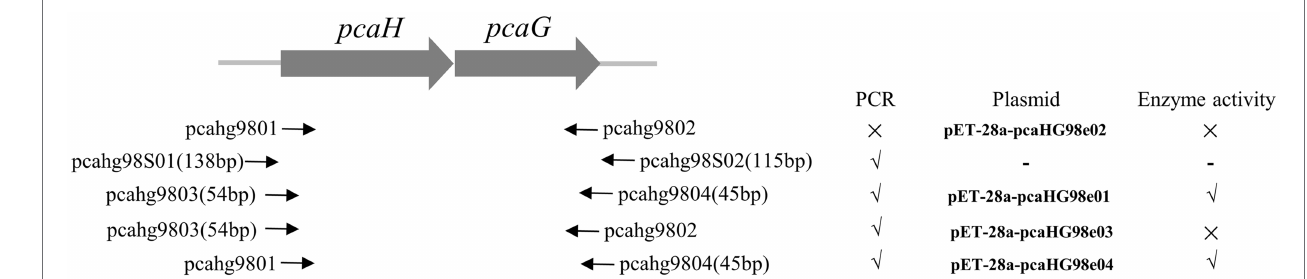
FIGURE 1 | Primers, PCR reactions, plasmids, and enzyme activity information used in this study. Primers are shown with a solid arrow. PCR without product (×) and with product ( √ ). Enzyme without activity (×) and with activity ( √